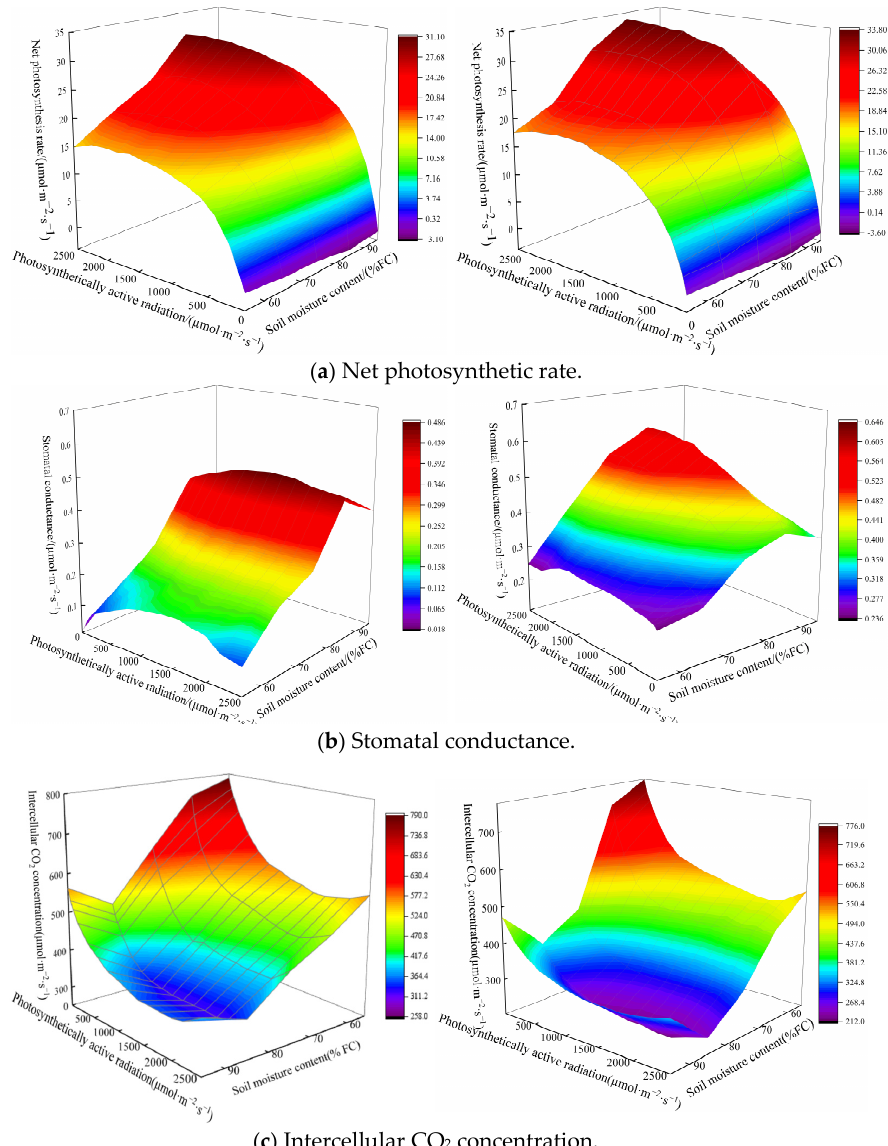
Figure 5. Response of the photosynthetic characteristics of spinach to photosynthetic effective radiation under different treatments. FC, field capacity. The left figure shows CK processing, and the right figure shows MD processing.